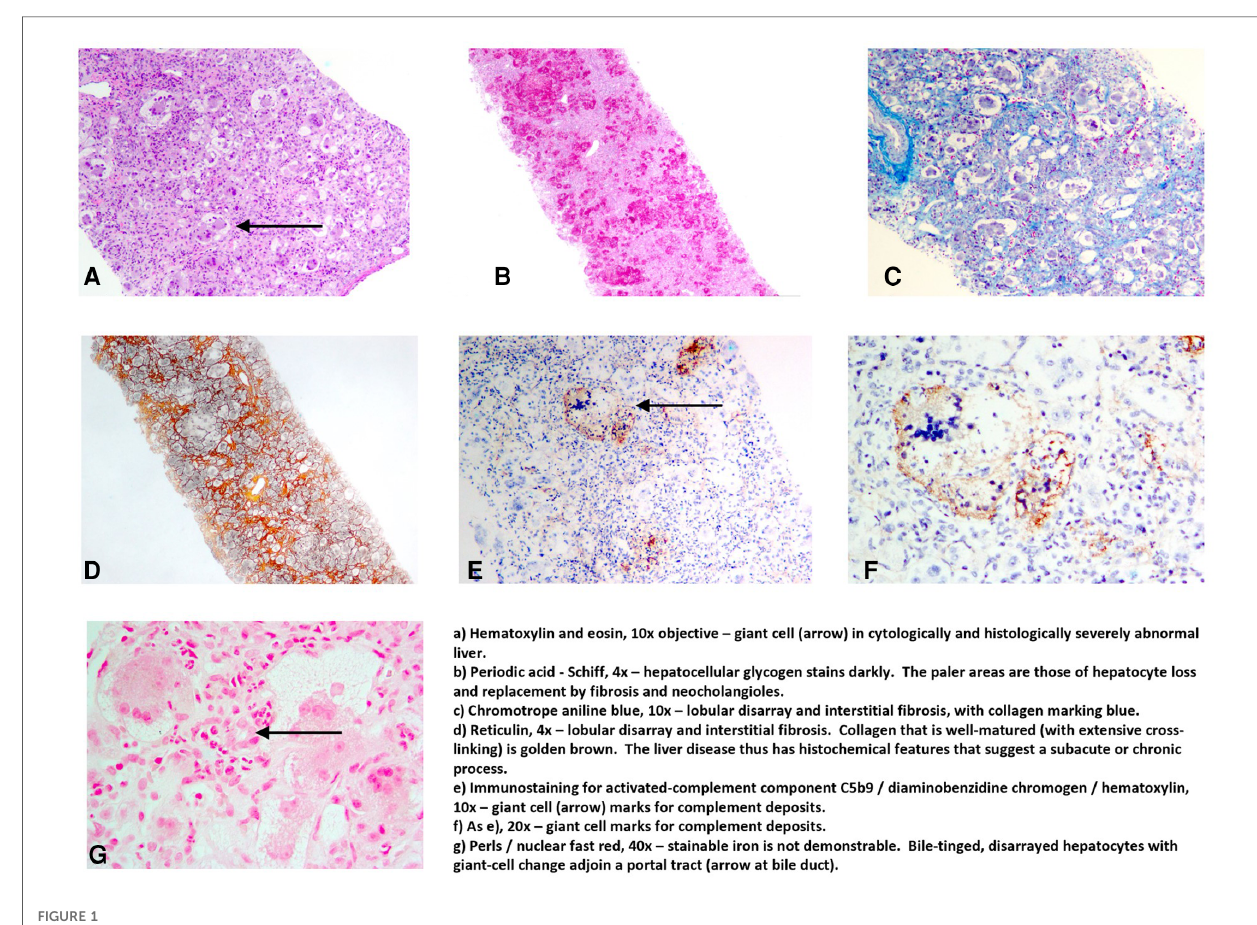
FIGURE 1 Photomicrographs, liver-biopsy specimen, A.S. Knisely,